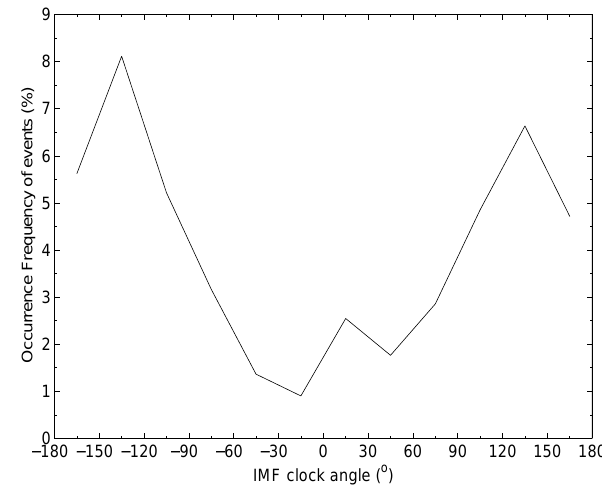
Fig. 4. Occurrence frequency of convection jets as a function of IMF clock